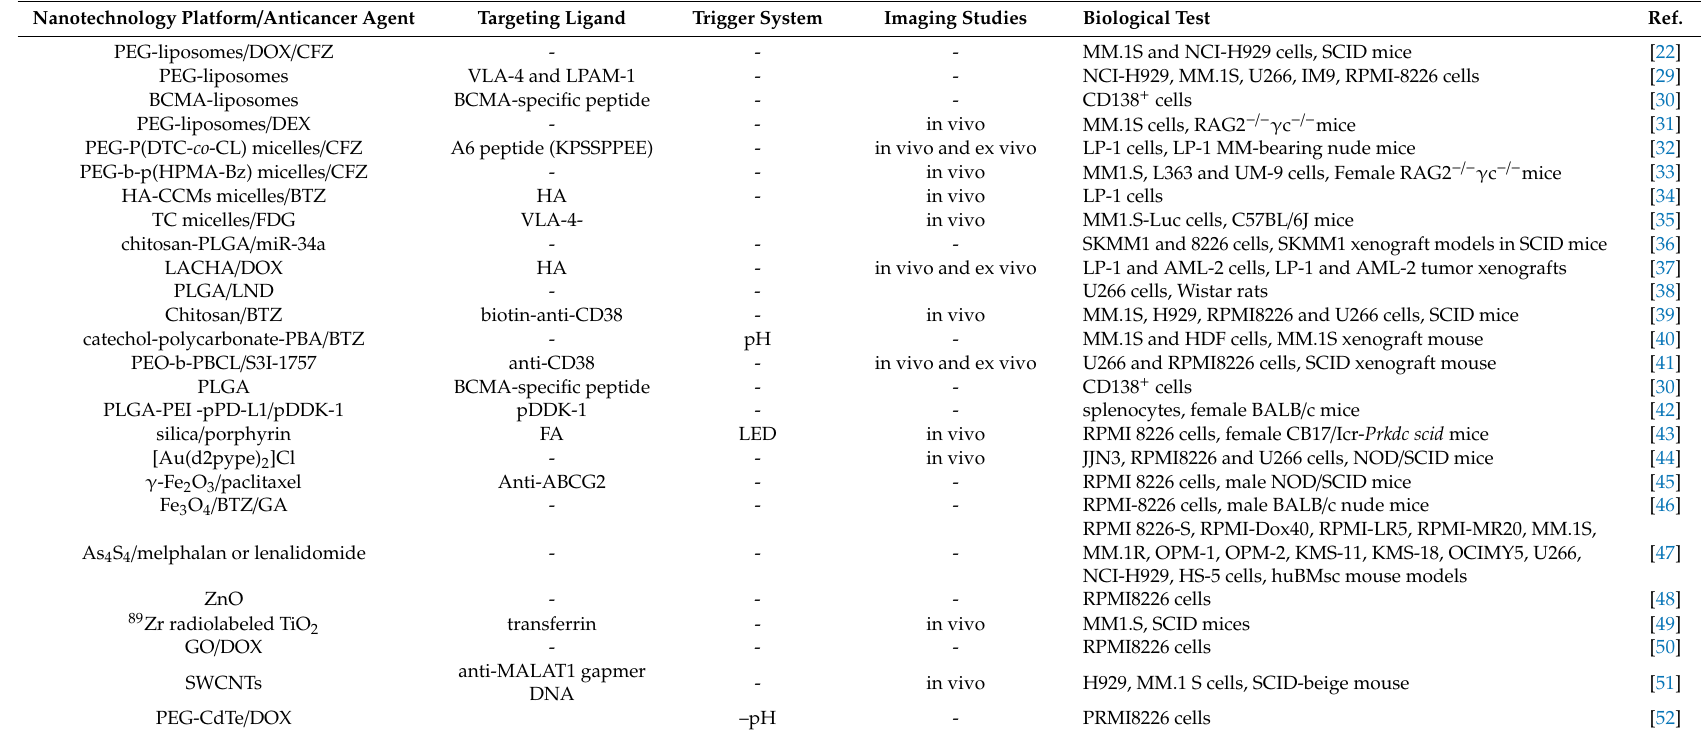
Table 1. Nanotherapeutics for MM